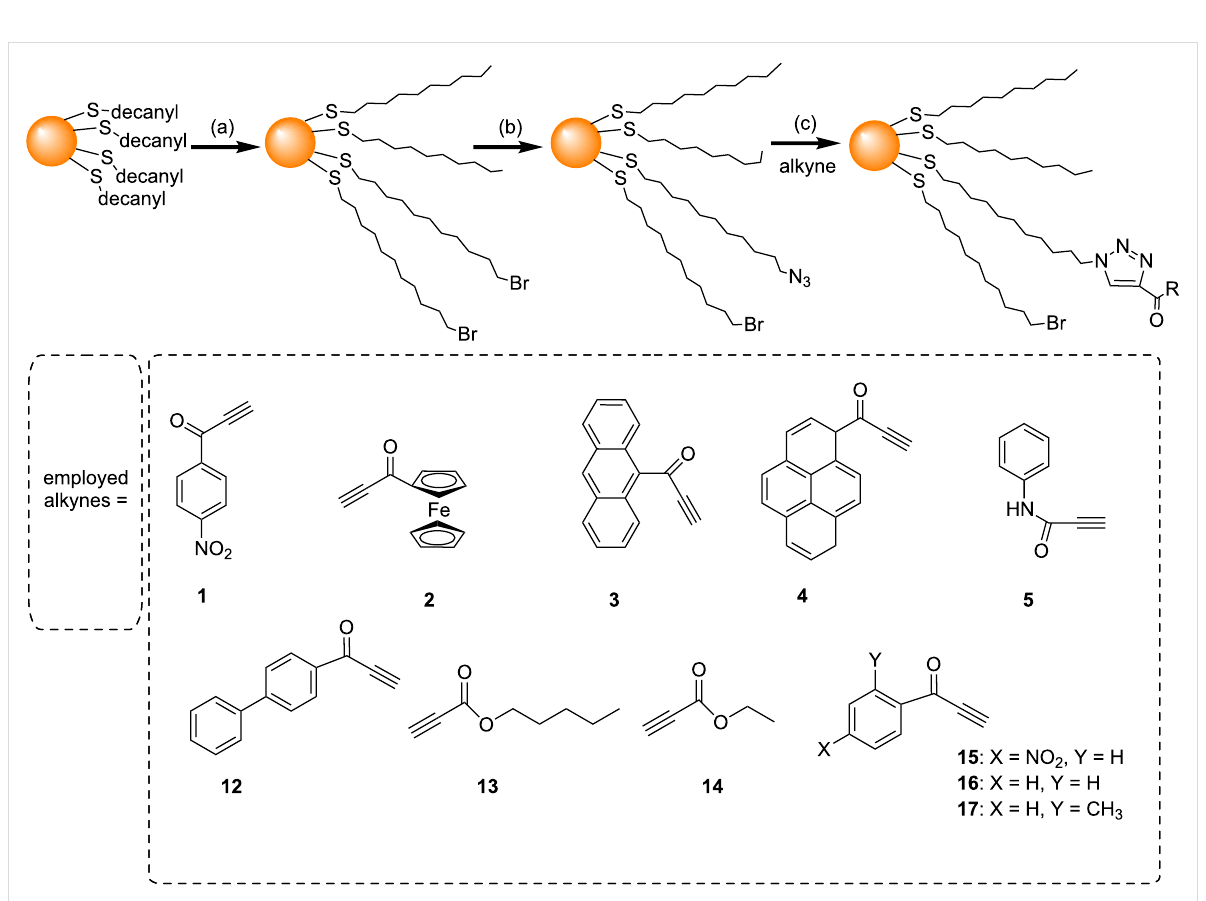
Scheme 4: NCAAC performed under hyperbaric conditions. Reagents and conditions: (a) Br(CH 2 ) 11 SH in C 6 H 6 , 48 h, rt; (b) NaN 3 in C 6 H 6 /DMSO, 48 h; (c) R = propyn-1-one derivatives, DCM, 11000 atm, 25 °C, 15–24 h